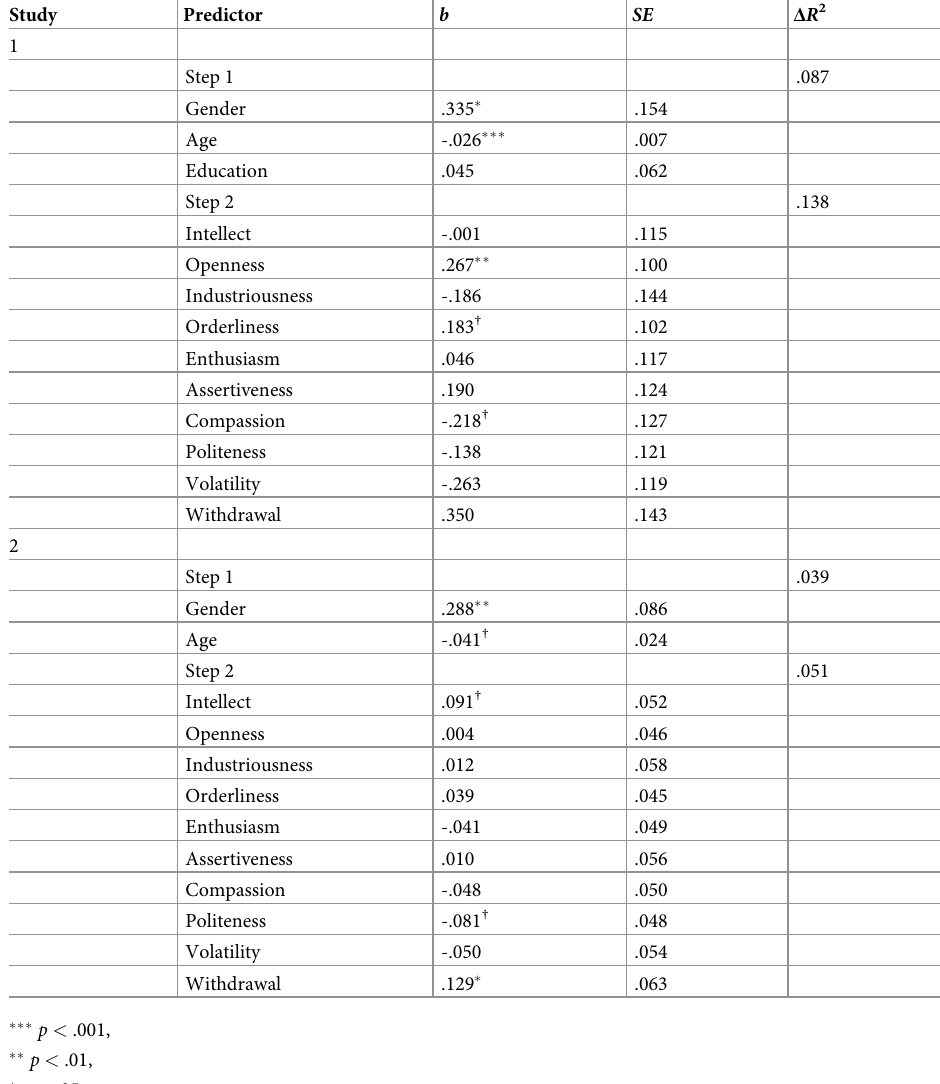
Table 6. Results of hierarchical regression analyses predicting scores on the